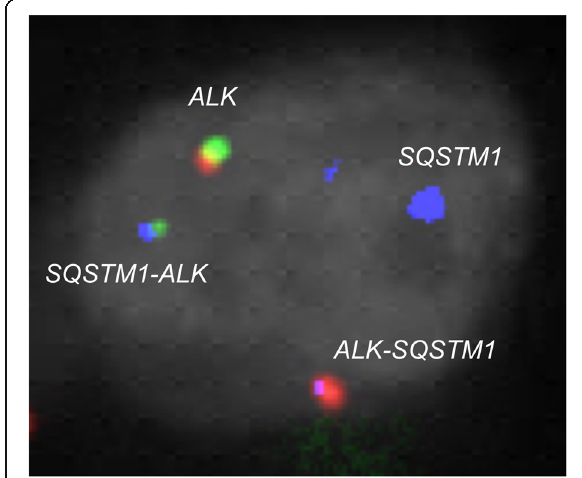
Fig. 8 Findings of fusion FISH for SQSTM1-ALK. 5 ’ SQSTM1 – 3 ’ ALK (blue-green) and 5 ’ ALK-3 ’ SQSTM1 (red-blue) signals were detected. Note that the colors of the probe flanking the breakpoint of the ALK gene are opposite to those seen in Fig.